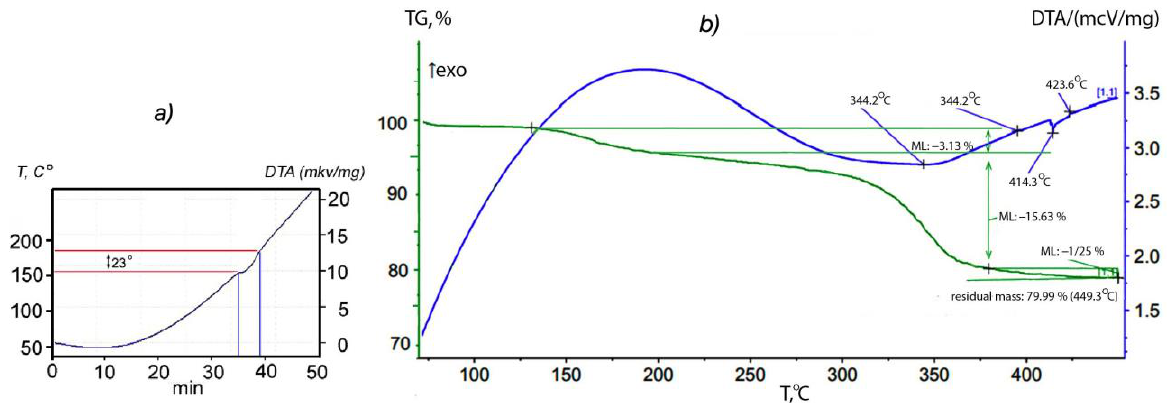
Figure 2. ( a ) Thermogram of a mixture consisting of the crystalline powders of In 1.2 Ga 0.8 S 3 and p-AP. ( b ) DTA and TG spectrum of the In 1.2 Ga 0.8 S 3 ·0.5(p-AP).